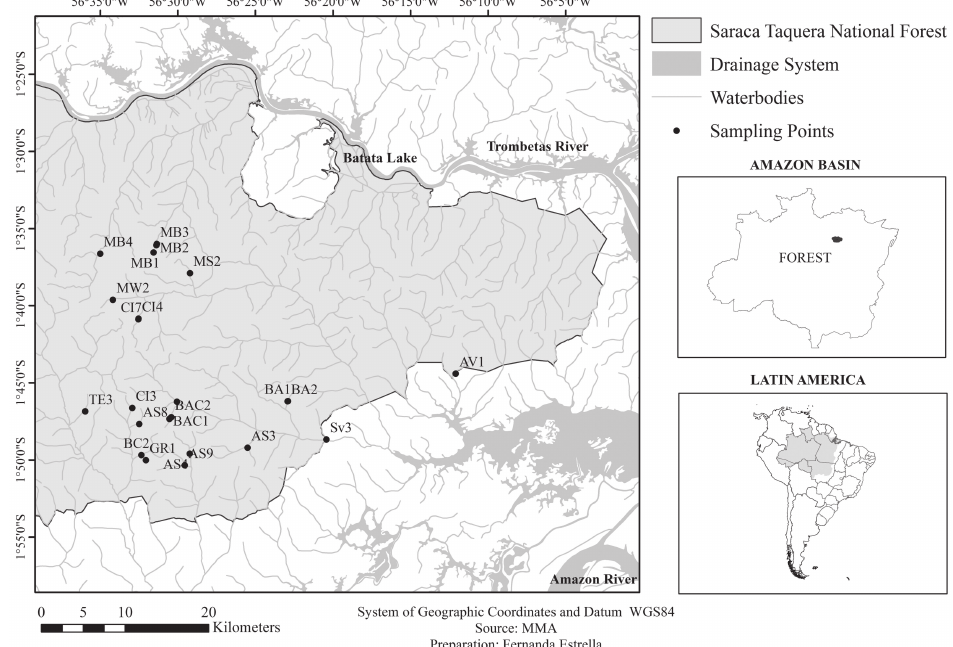
Fig. 1. Study area depicting sampled streams in the Saracá-Taquera National Forest, Pará,